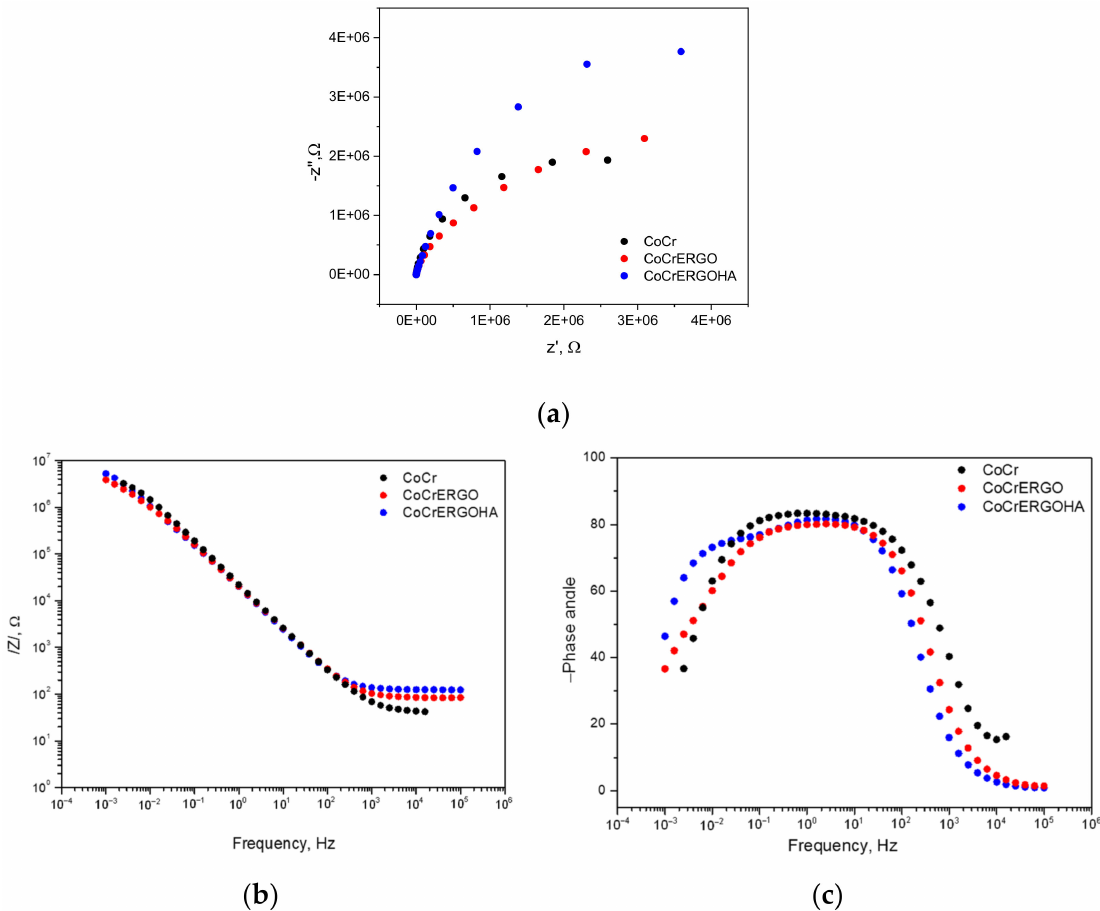
Figure 2. Nyquist diagrams ( a ) and Bode diagrams of impedance modulus ( b ) and phase angle ( c ) versus frequency, for CoCr, CoCrErGO, and CoCrErGOHA surfaces after 7 days of immersion in